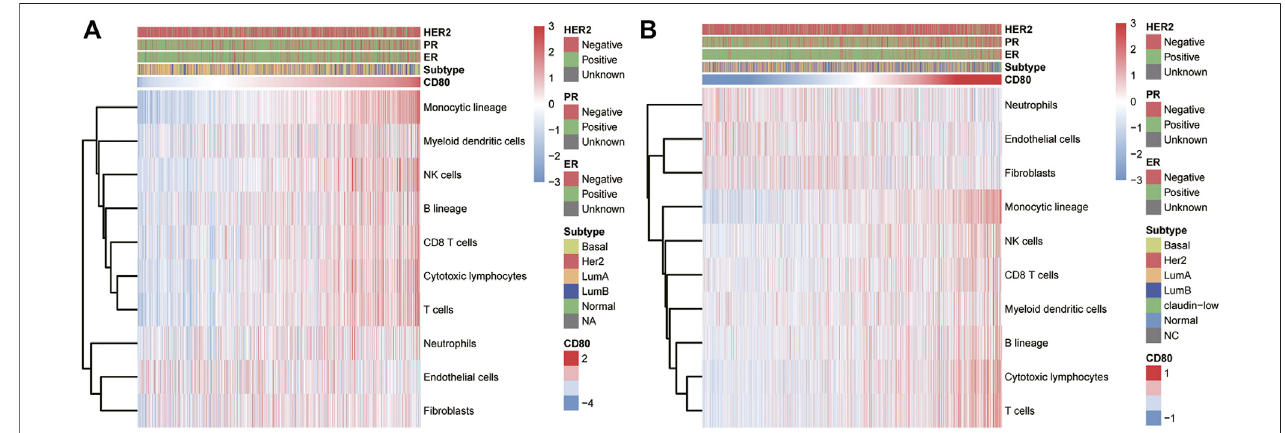
FIGURE 5 | Association between the CD80 expression and immune cell populations in the TCGA and METABRIC cohort (A,B) .